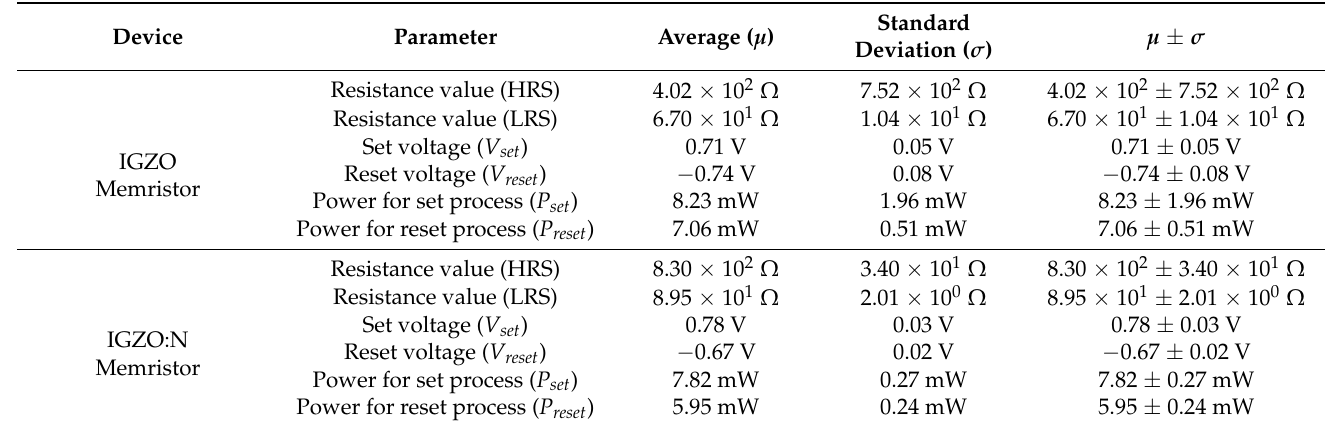
Table 3. Total BRS operation parameters of IGZO and IGZO:N memristor devices.